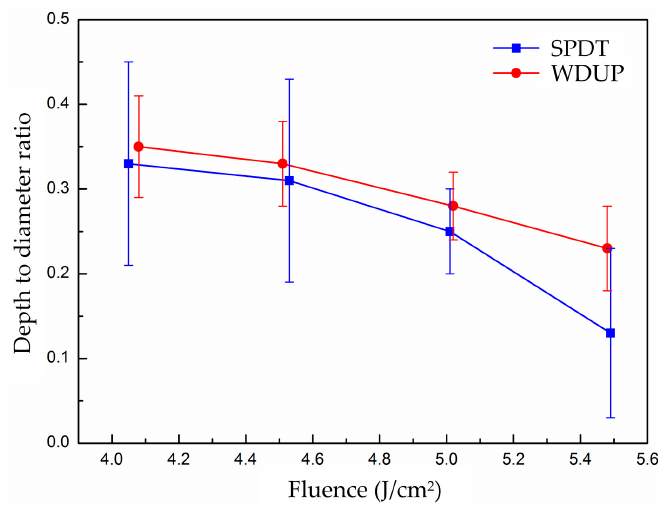
Figure 12. Depth to diameter ratio of damage crater versus laser fluence of KDP crystal processed with SPDT and WDUP.